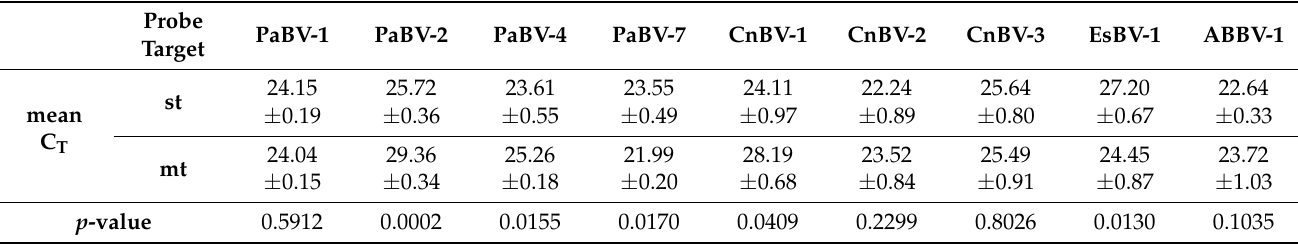
Table 3. Impact of the presence of multiple avian bornavirus RNAs on the rRT-PCR performance. Comparison between multiple RNA targets vs. a single target RNA (10 6 copies per reaction).